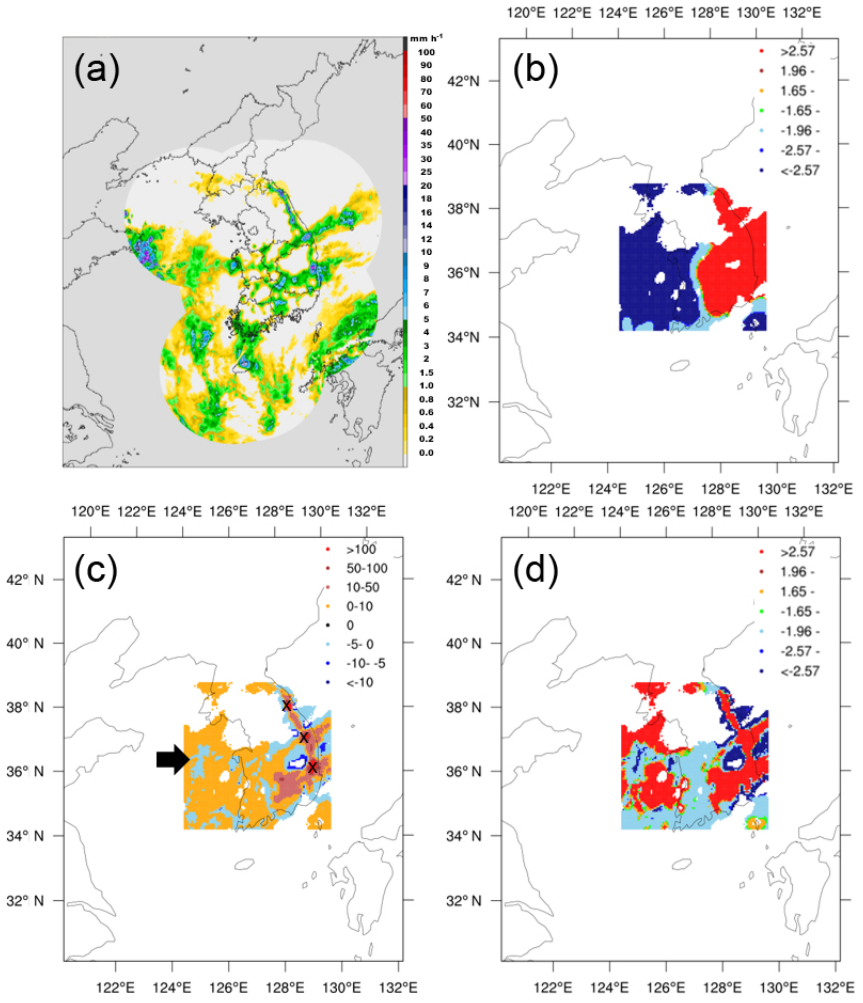
Figure 9. An LPMP case at 05:00KST on 25 August 2015: (a) precipitation distribution (from https://afso.kma.go.kr/, last access: 10 Febru- ary 2018), (b) local Z(G i ) , (c) local Moran’s I ( I i ), and (d) Z score of I i . The computational domain covers the area of 34.34–38.97 ◦ N and 124.25–130.05 ◦ E. Precipitation systems with maximum intensity and strong cluster characteristics are marked by the X symbols, and the cold spots with dispersion pattern are denoted by the arrow. Non-precipitating areas have no color shading.